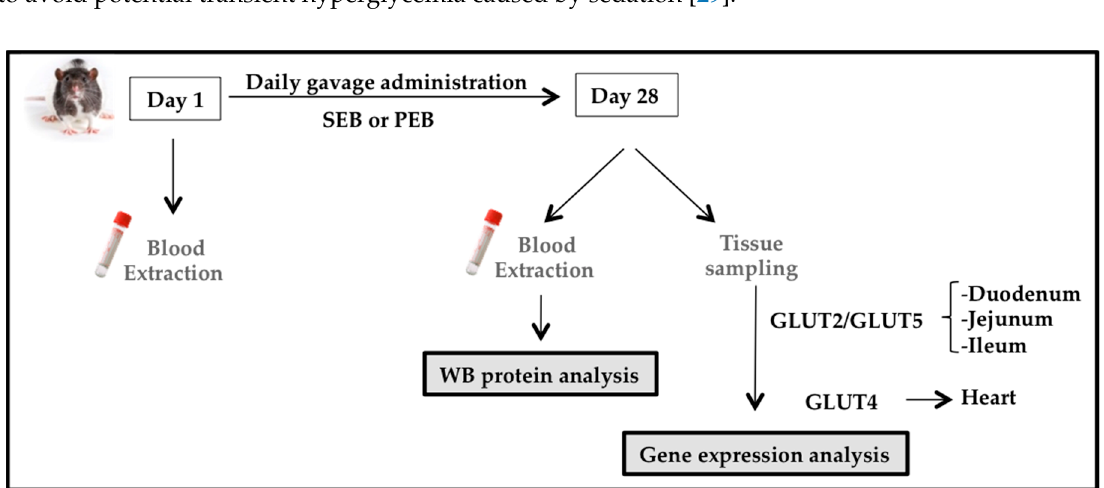
Figure 2. Zucker diabetic fatty (ZDF) rat study design. Blood samples were obtained at baseline and after 28 days of sucrose/pinitol-enriched beverage administration. Tissues were obtained, frozen in liquid nitrogen and stored at − 80 °C until used.